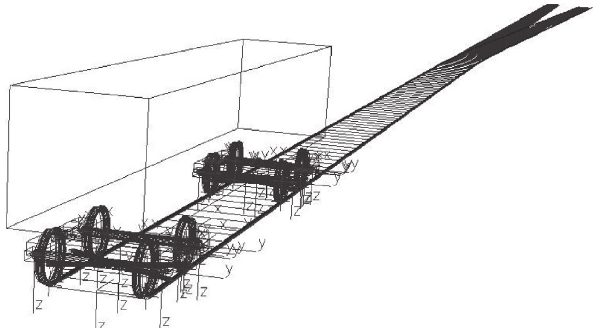
Figure 6: The vehicle-turnout system dynamic